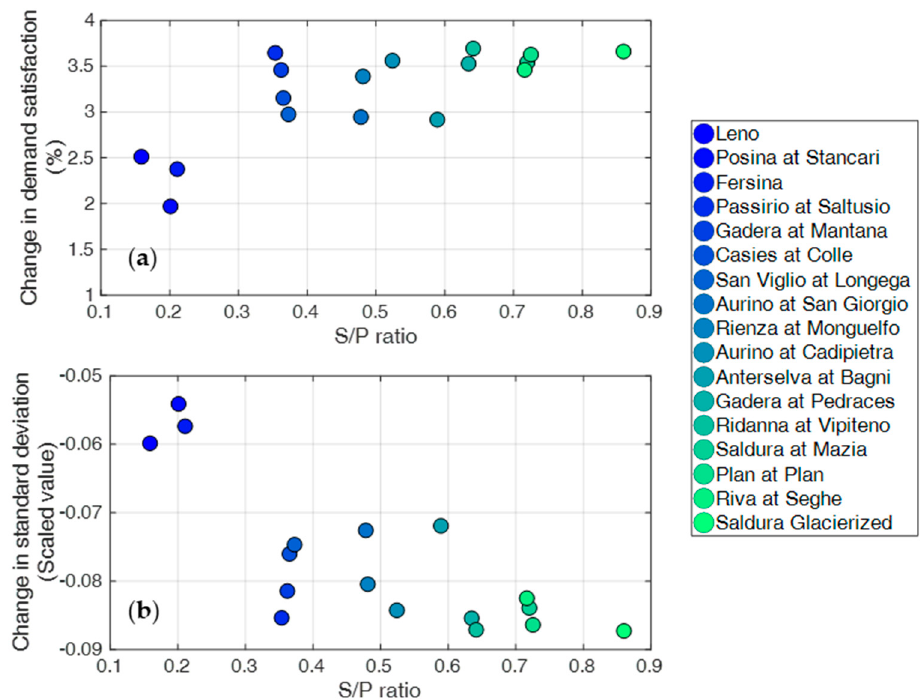
Figure 5. Change in electricity demand satisfaction ( a ) and electricity balance variability ( b ) when moving from an urban / sub-urban area with no district heating system ( H s = 0) to an area equipped with a district heating system covering 100% of the heat demand (i.e., H s = 1 ). The considered districts are ordered according to their ratio between snowfall and total precipitation (S / P). The change in demand satisfaction is obtained by comparing the demand satisfaction (or the standard deviation of the electricity balance) for the best energy mix with or without CHP plants within the district (i.e., either H s = 0 or H s = 1 ).